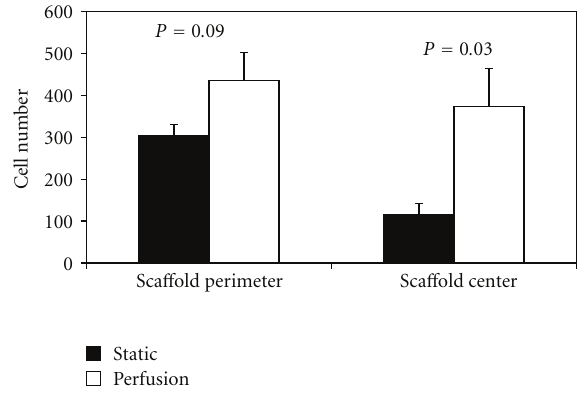
Figure 6: Cell number is increased in three-dimensional sca ff olds when exposed to perfusion flow for 14 days. Periphery is mean value of the 8 peripheral